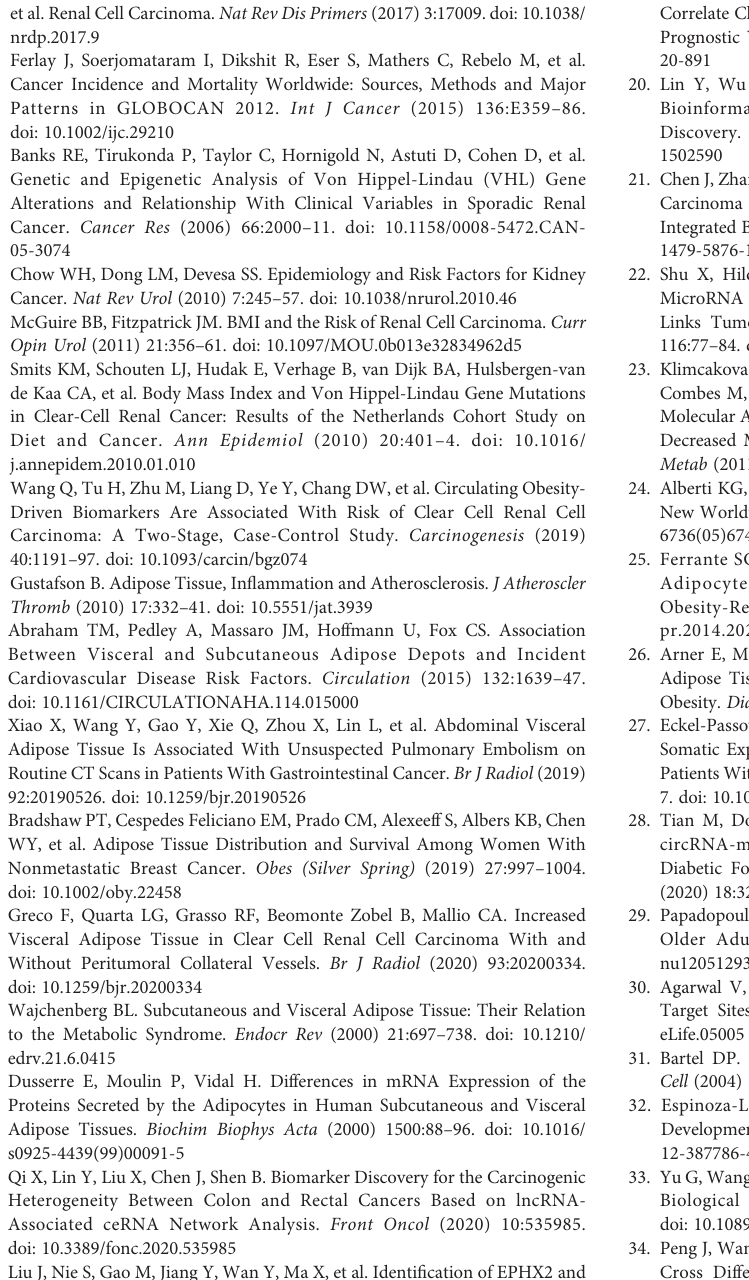
Supplementary Figure 2 | ResultsofGOenrichmentanalysesinVAT (A – C) andSAT (D – F) . (A,D) :resultsofbiologicalprocess(BP)functionalenrichmentinmRNAsofVAT (A) andSAT (D) ; (B,E) :resultsofmolecularfunction(MF)functionalenrichmentinmRNAsof VAT (B) andSAT (E) ; (C, F) : resultsofcellular component(CC) functionalenrichmentin mRNAs ofVAT (C) andSAT (F) . The color from